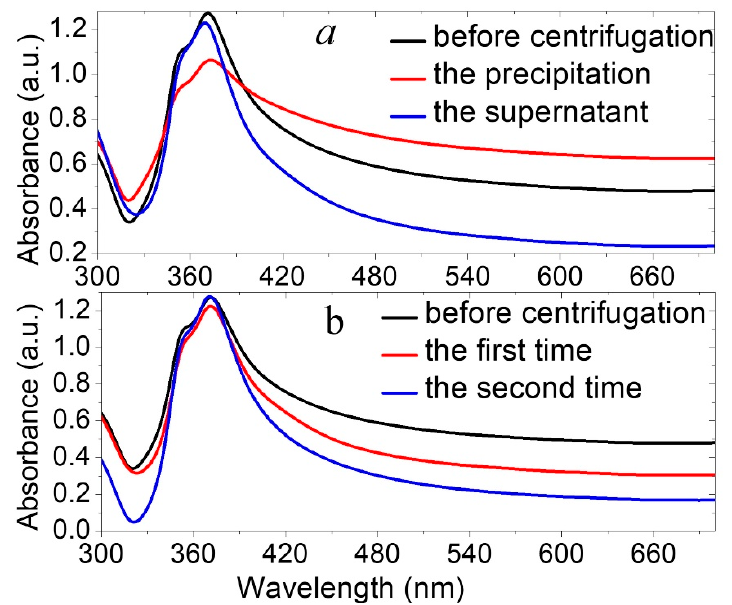
Figure 5. The absorption spectra of AgNWs (grown at 150 °C) during the purification process: ( a ) before the centrifuge, and the supernatant and precipitation after the centrifuge at 1500 rpm. ( b ) before the centrifuge, and centrifugation of supernatant twice at 7000 rpm.